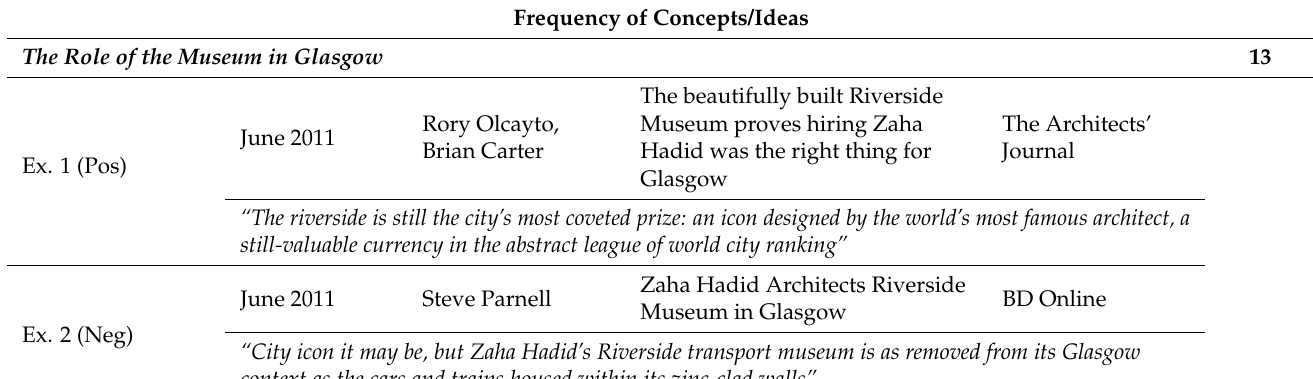
Table 4. Frequency of concepts and key ideas and examples of positive and negative statements on the Riverside Museum in